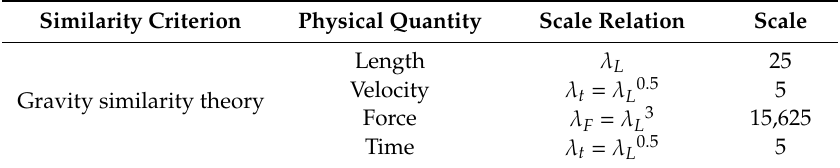
Figure 5. Schematic of physical model experiment and force measurement ( a ) test site; ( b ) TCC; ( c ) schematic of force measurement (measured parameters: flow velocity (v), pulling force (T), gravity of the rubber block (G), bottom friction coefficient ( 𝜇 ), angle between pulling force and flow direction ( 𝜃 ), and water depth (H)). Table 1. Experimental hydraulic parameters and geometric